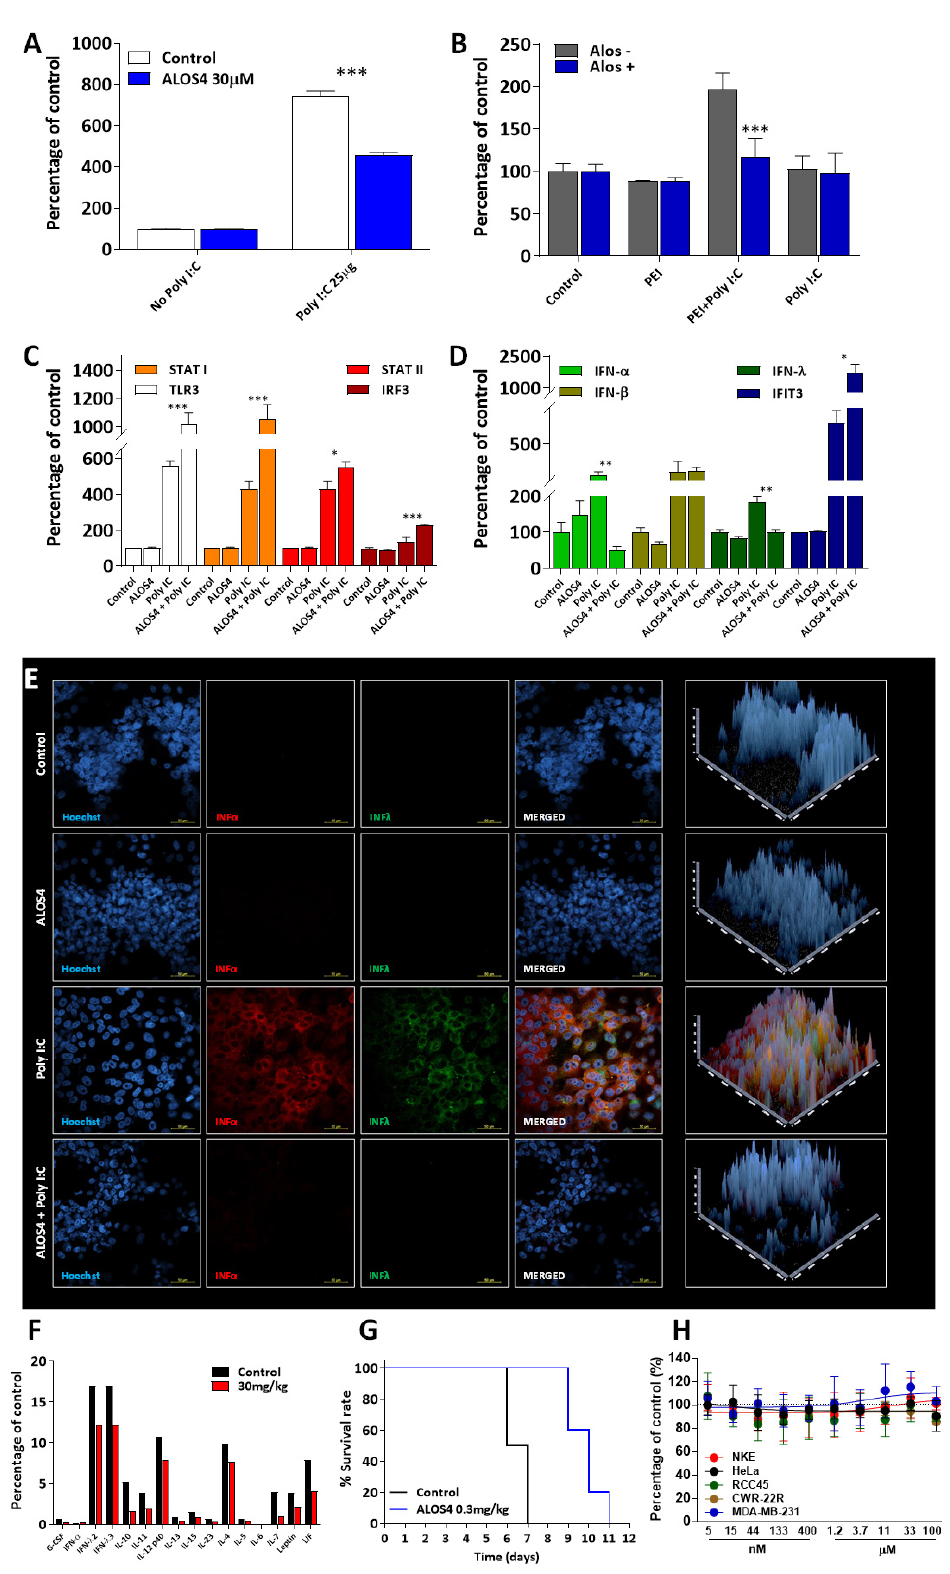
Figure 1. ALOS4 suppresses pro-inflammatory signaling. ( A ) A synthetic analog of viral dsRNA (Poly I:C, 25 µg/mL) was used to induce interferon type I signaling in HT1080-ISRE-mCherry cells. IFN response was suppressed with 30 µM ALOS4 pretreatment for 48 h. Multiple reads (8 per well) at 574 Ex /610 Em . ( B ) Pretreatment with 0.3 µM of ALOS4 HCT116-ISRE-Luc cells in the presence of 0.1